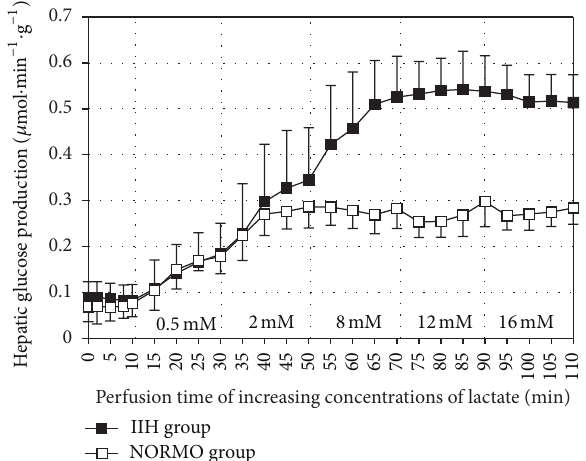
Figure 1: Demonstrative experiments ( 𝑛 = 3 - 4 ) of glucose produc- tion from increasing concentrations of lactate in perfused liver of fasted mice that received intraperitoneal injection of insulin (IIH group, – ◼ –) or saline (NORMO group, – ◻ –). The effluent fluid was collectedat5 minintervalsandanalyzedforglucose.Theareasunder curve (the increment of glucose production between 10 and 110min) of NORMO and IIH group were 39.51 ± 0.19 and 24.96 ± 0.09 ,